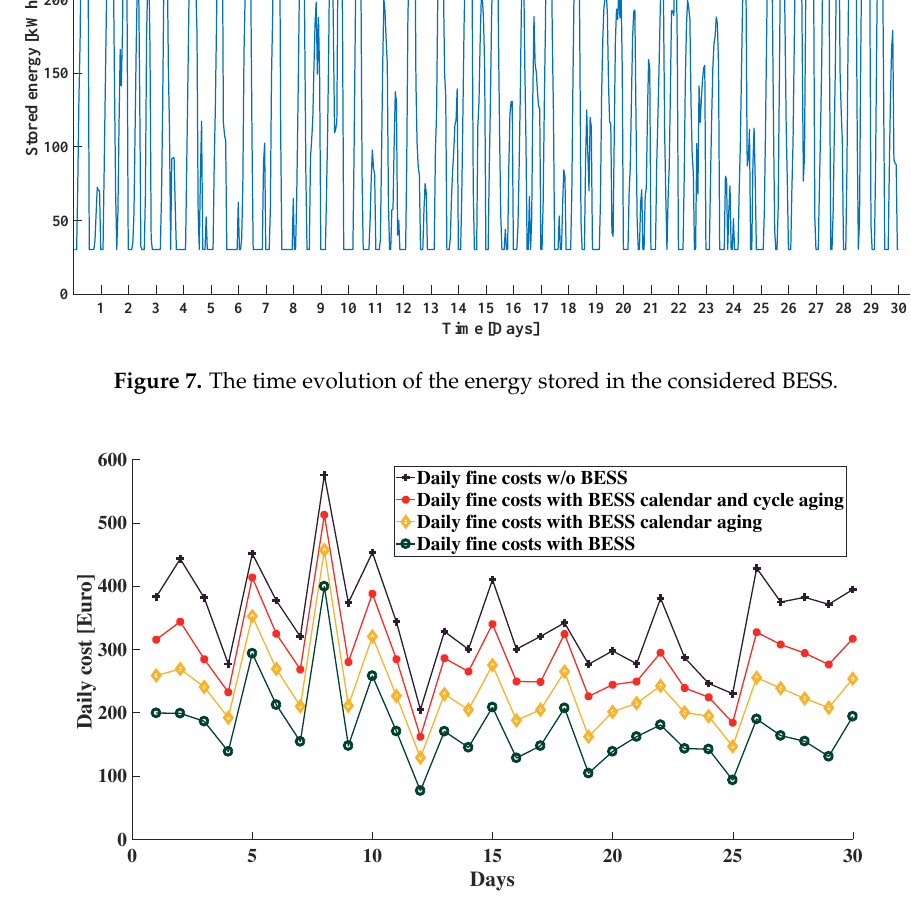
Figure 8. The daily cost of the system. The fine cost and the BESS calendar and cycling aging amortization costs are given as a sum. Also, the daily fine cost of the system without the BESS is given as a